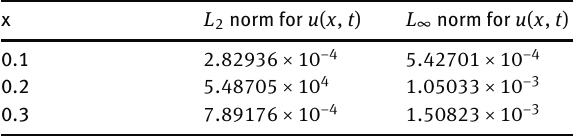
Table 2: L 2 and L ∞ error norm in case of STO equation using MHATM at various points of x when α = 1